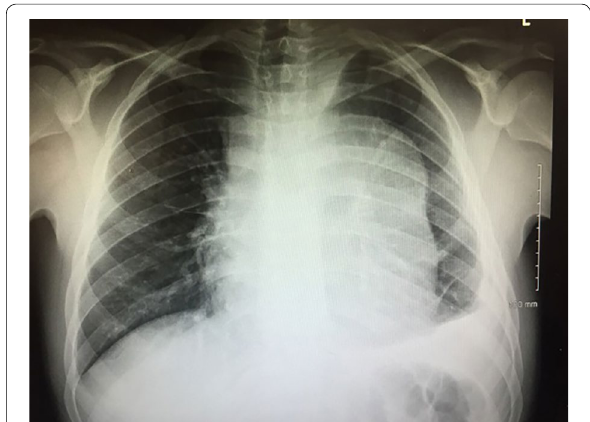
Fig. 2 Chest radiograph, Case 2. This AP chest radiograph exhibits a